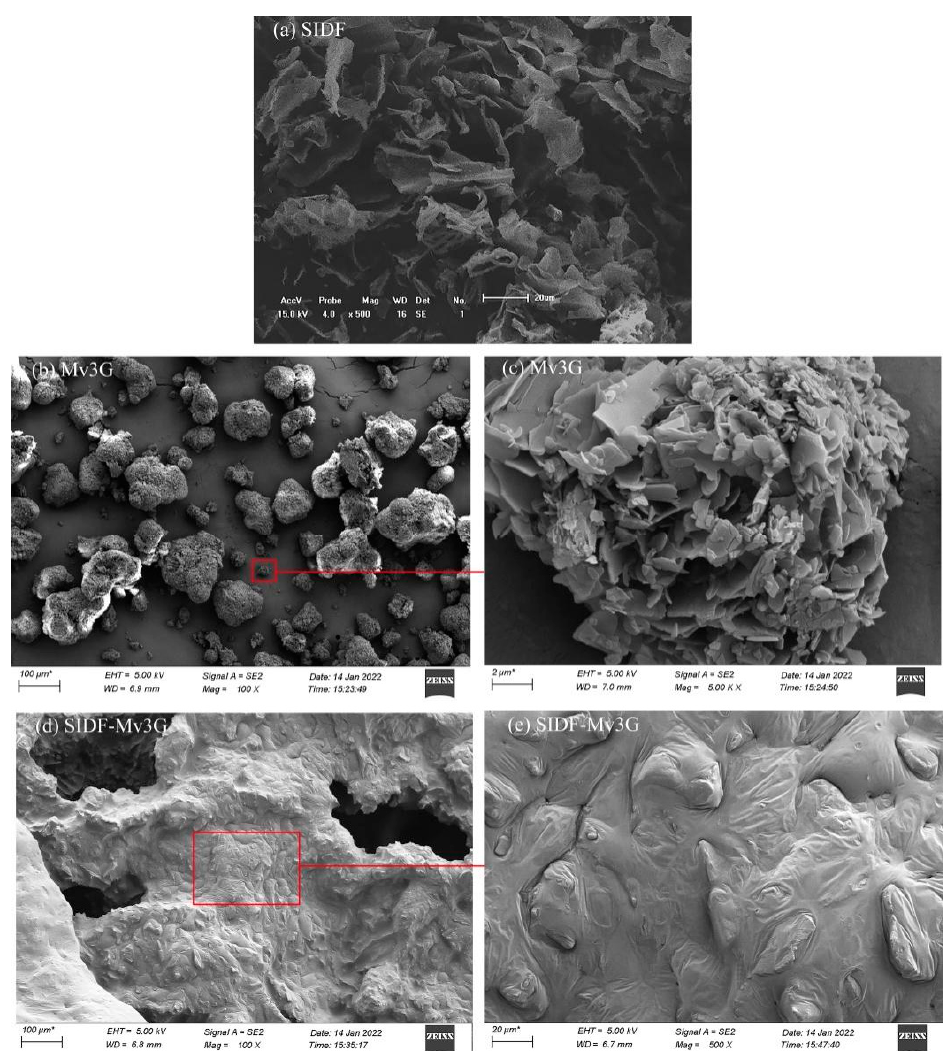
Figure 7. Scanning electron microscopy. SIDF-Mv3G: the stability system of soybean insoluble dietary fiber and malvidin-3- O -glucoside; Mv3G: malvidin-3- O -glucoside; SIDF: soybean insoluble dietary fiber. ( a ) Scanning electron microscope image of SIDF (×500); ( b ) scanning electron microscope image of Mv3G (×100); ( c ) scanning electron microscope image of Mv3G (×5000); ( d ) scanning electron microscope image of SIDF-Mv3G (×100); ( e ) scanning electron microscope image of SIDF-Mv3G (×500).